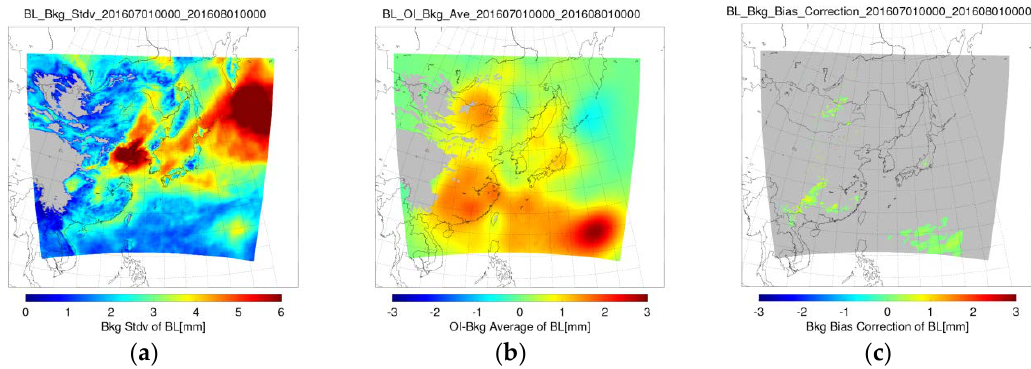
Figure 7. An example of the valid bias region analysis (July 2016). ( a ) Bkg Stdv in the BL; ( b ) the expected OI-B in the BL; and ( c ) the valid OI-B region in the BL.